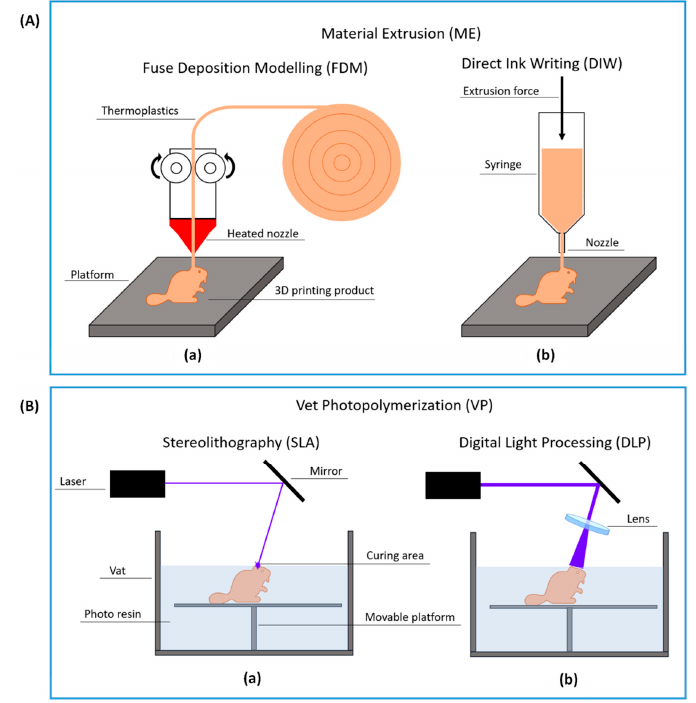
Figure 1. Common 3D print methods. ( A ) Material extrusion (ME): ( a ) fused deposition modeling (FDM) and ( b ) direct ink writing (DIW) ( B ) vat photopolymerization (VP): ( a ) stereolithography (SLA) and ( b ) digital light processing (DLP).